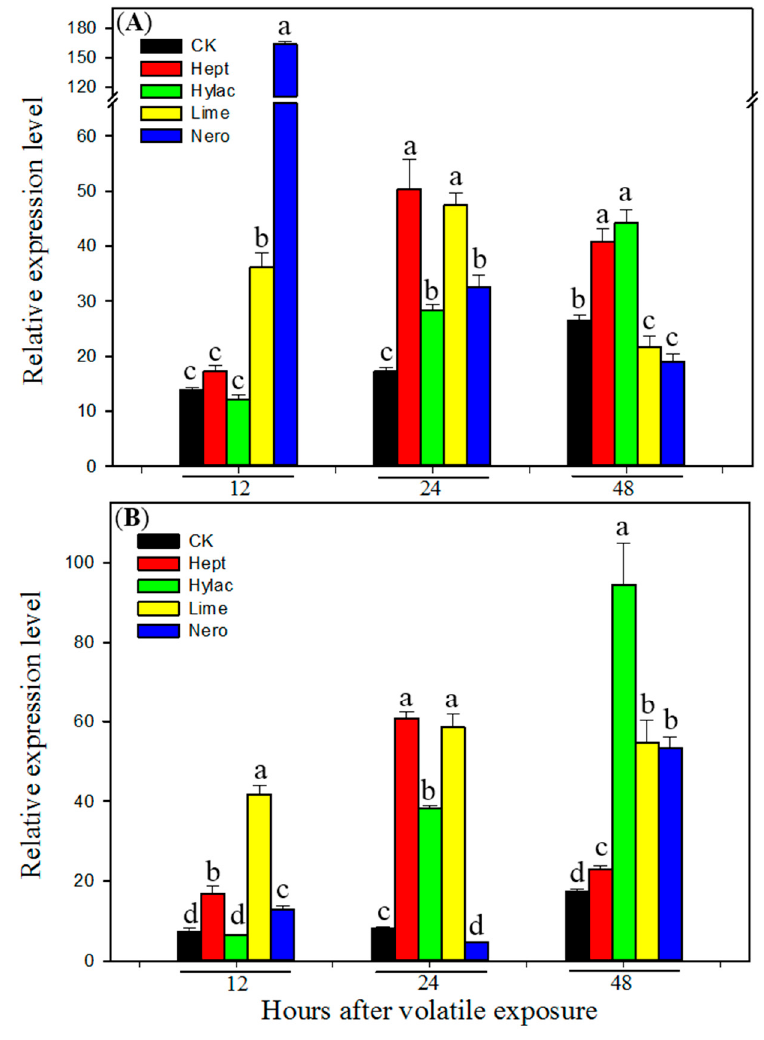
Figure 2. Transcript levels of CYP6B2 in midguts ( A ) and fat bodies ( B ) of fifth instar larvae of Helicoverpa armigera exposed to plant volatiles. Newly molted fifth instars were individually exposed to volatile 2-heptanone (Hept), cis -3-hexenyl acetate (Hylac), limonene (Limo) and nerolidol (Nero) at a dose of 1 µ L per cup for 12, 24 or 48 h, respectively in a sealed cup. Then the midguts and fat bodies were dissected. Total RNA was pooled from midguts or fat bodies of 20 fifth instar H. armigera larvae exposed to different plant volatile for 12, 24 and 48 h. Control larvae (CK) were fed with diet without plant volatile. Real-time qRT-PCR analysis was conducted to determine the relative transcript levels of the gene. Data shown are means ± SE derived from three biological repeats ( n = 3). Different letters above bars indicate significant differences ( p < 0.05 using ANOVA followed by a Tukey test for post-hoc comparison).